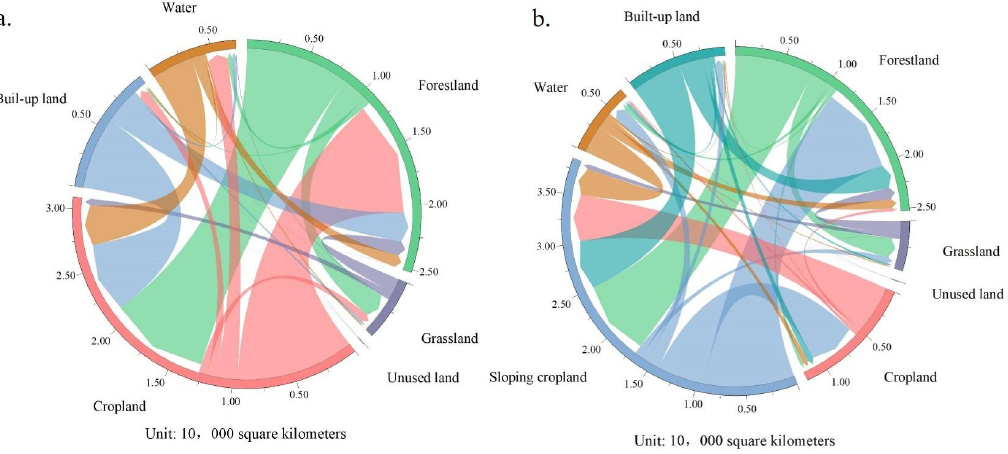
Figure 4. Land-use transfer flows in the MRYRR from 2000 to 2020. ( a ) Transfers between cropland and other land-use types. ( b ) Transfers between sloping cropland and other land-use types.